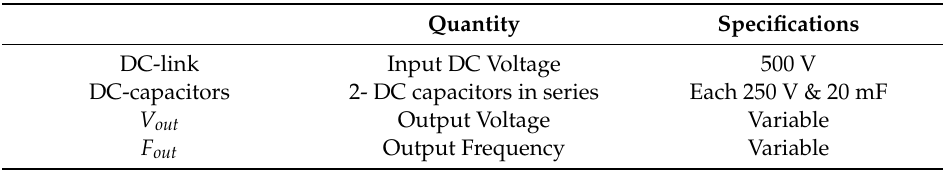
Table 3. Voltage source inverter (VSI) specifications for SST.